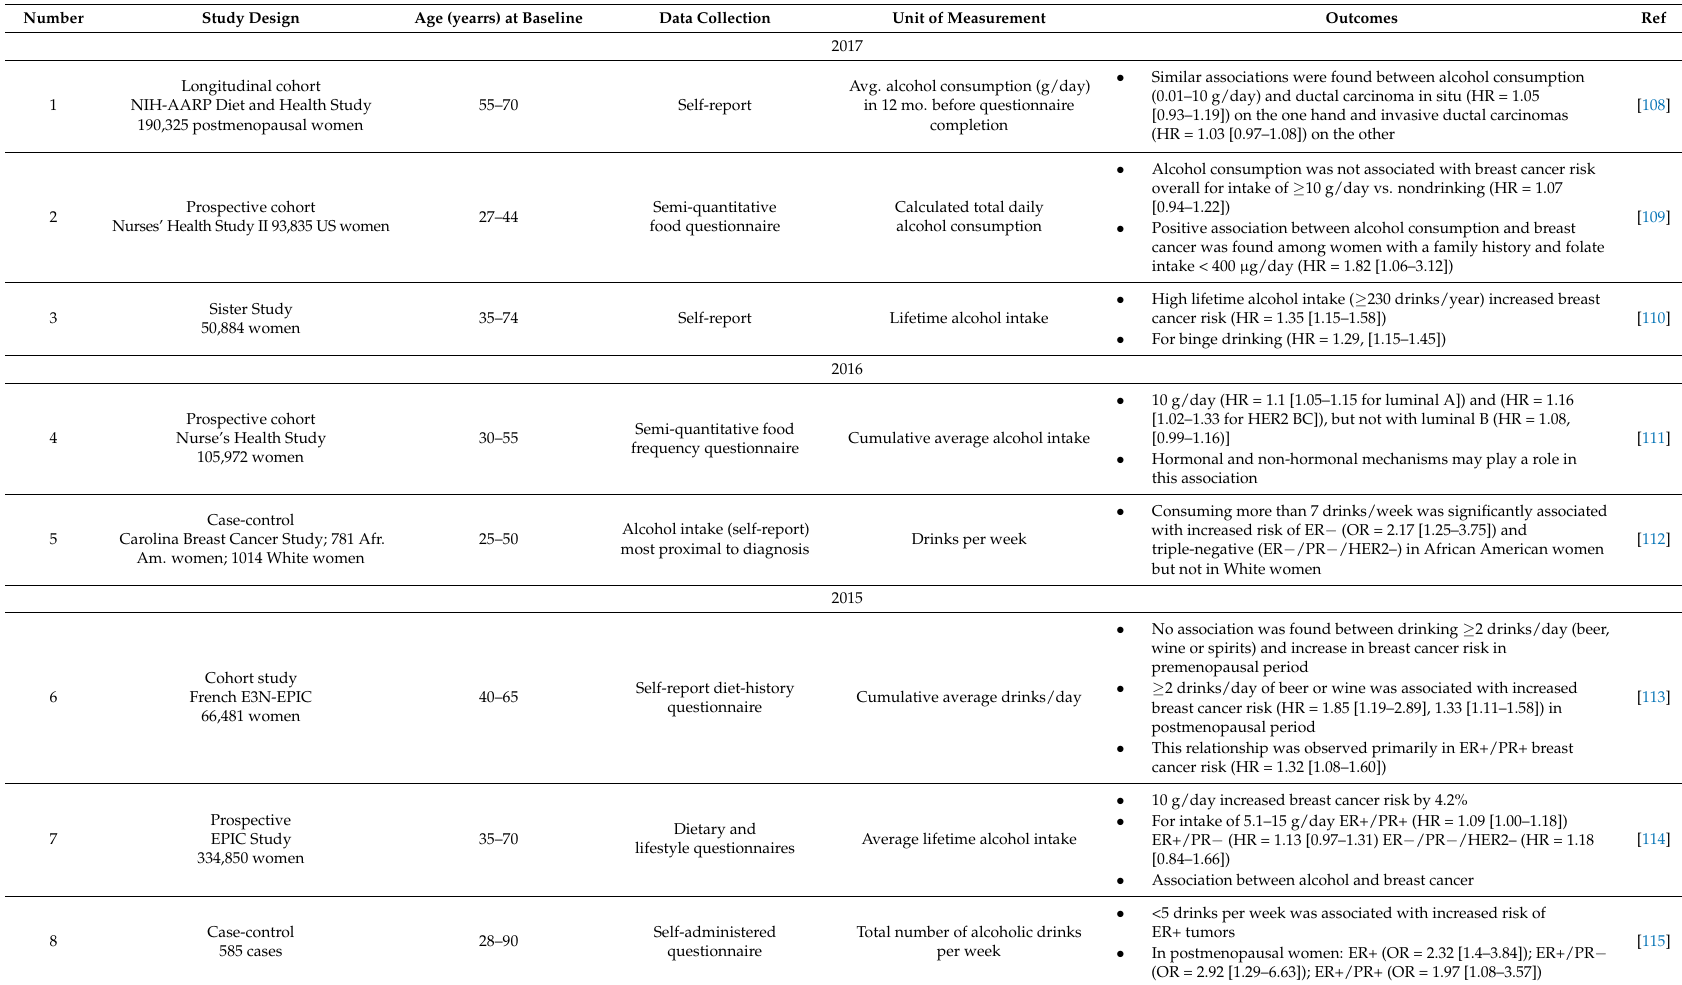
Table 1. Alcohol and Breast Cancer: Recent Epidemiological